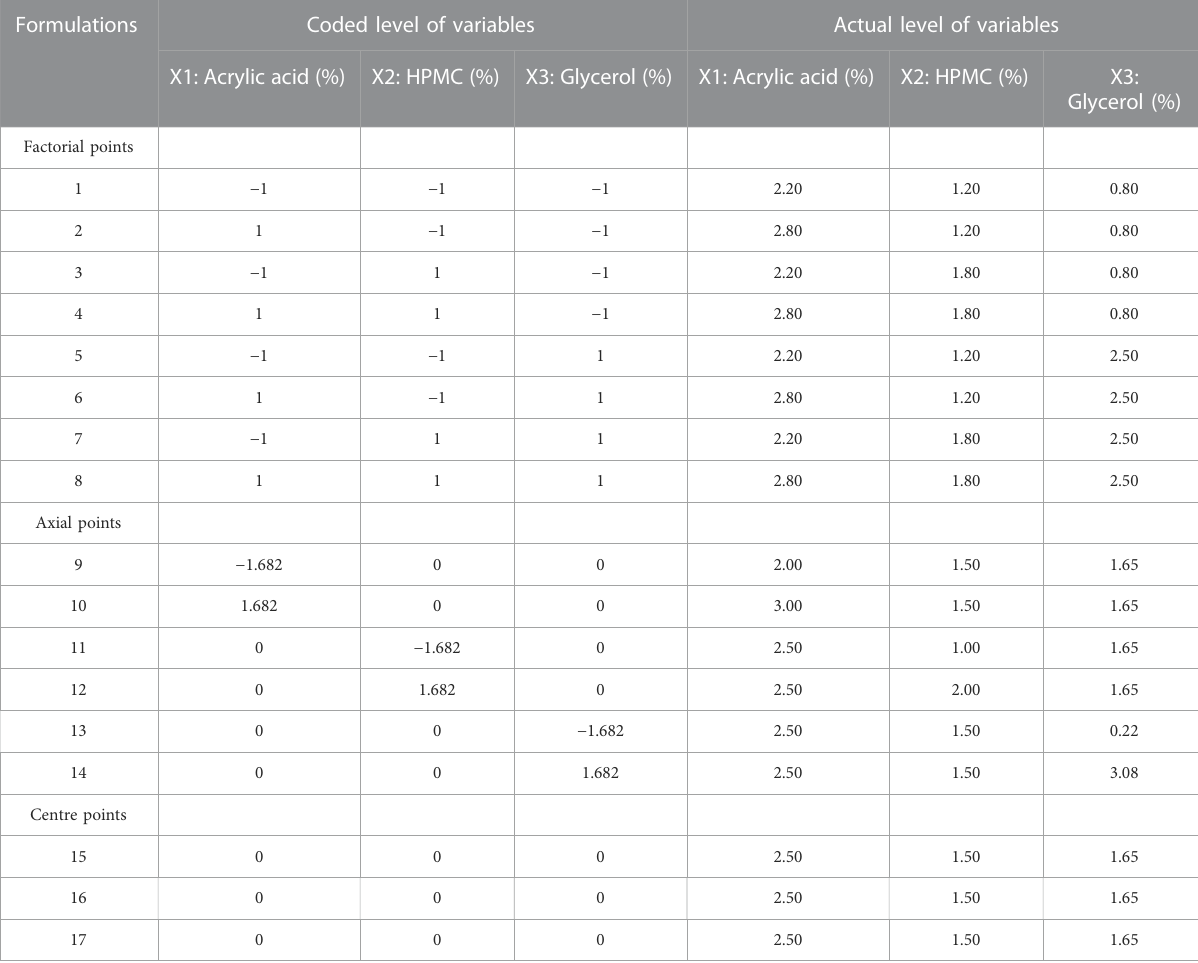
TABLE 1 Coded central composite design for three